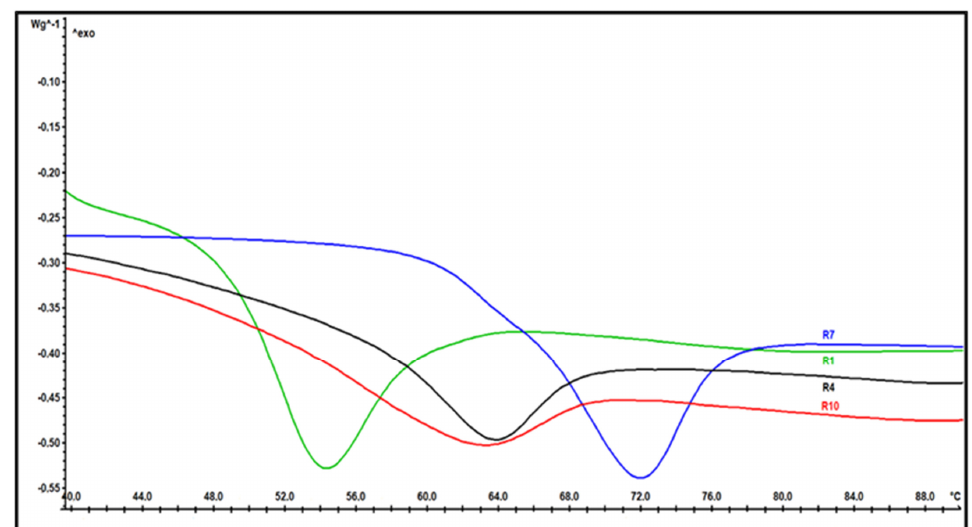
Figure 3. Differential scanning calorimetry (DSC) thermograms of four synthesized resins (basic– R1, with aminosilane–R4, with COSI–R7, and with ZnAl-LDH–R10).